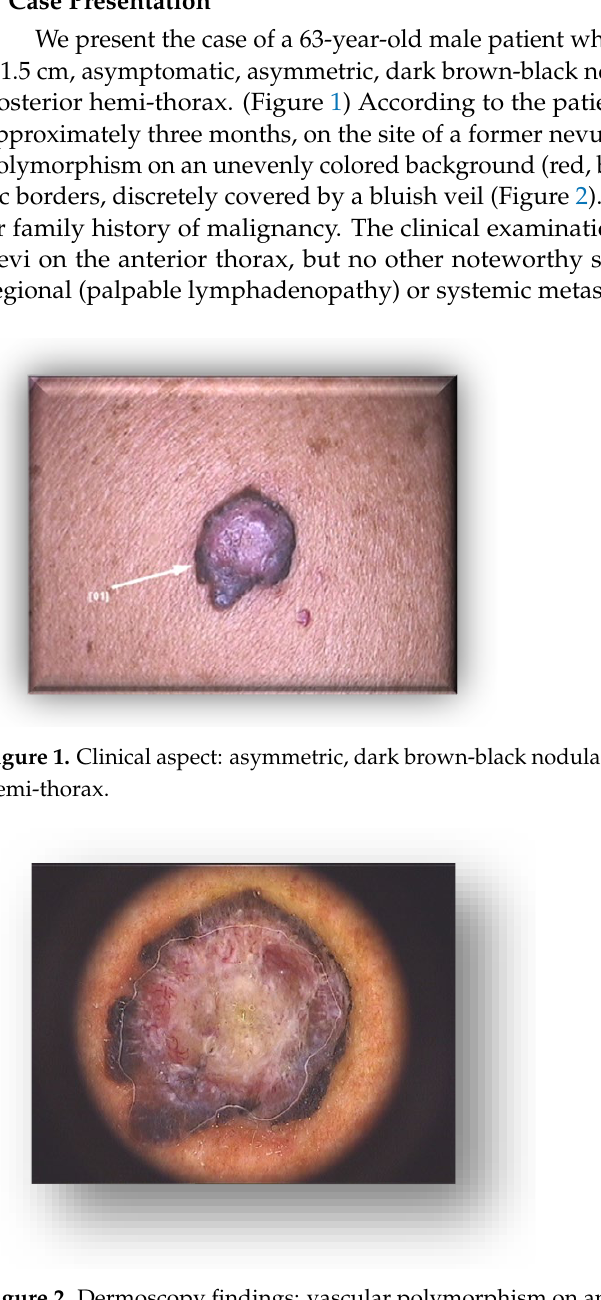
Figure 2. Dermoscopy findings: vascular polymorphism on an unevenly colored background (red, black, dark brown) with asymmetric borders, discretely covered by a bluish veil.